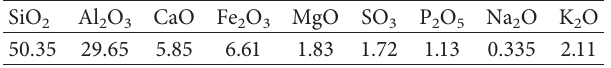
Table 1: Chemical composition of Class III fly ash